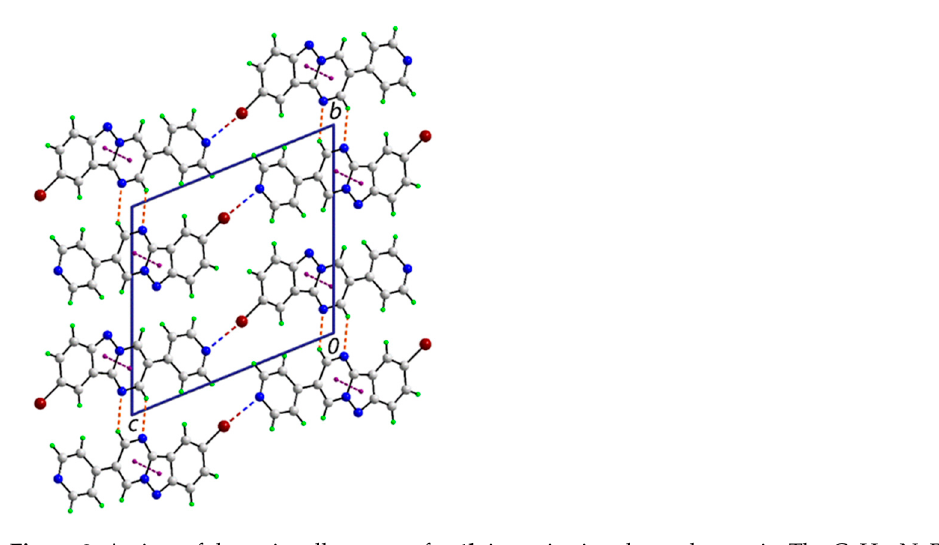
Figure 2. A view of the unit-cell contents for 1b in projection down the a -axis. The C–H ··· N, Br ··· N and π ··· π contacts are shown as orange, blue/brown and purple dashed lines, respectively. Table 2. Geometric parameters characterising the specified intermolecular contacts for 1b and 1c